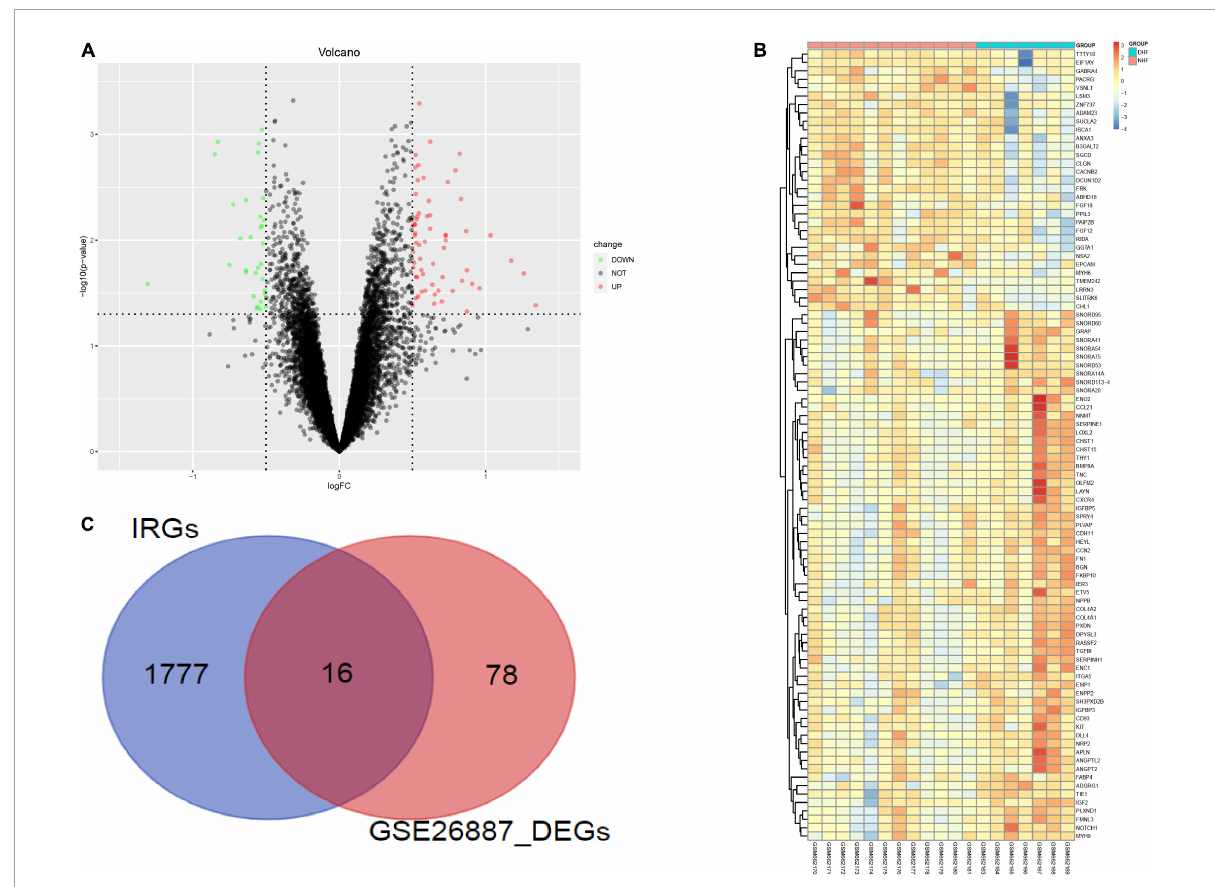
FIGURE2 Identification of differential genes related to immunity. (A) DEGs between DHF patients and NHF patients (Red, up-regulated in DHF; green, down-regulated in NHF). (B) Heatmap of 94 DEGs. (C) Intersection of DEGs and immune related